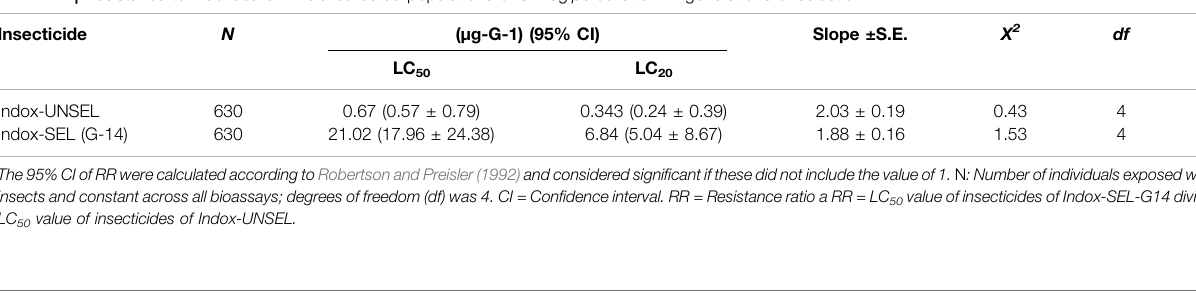
TABLE 2 | Resistance to indoxacarb in fi eld-collected populations of S. frugiperda after 14 generations of selection. Insecticide